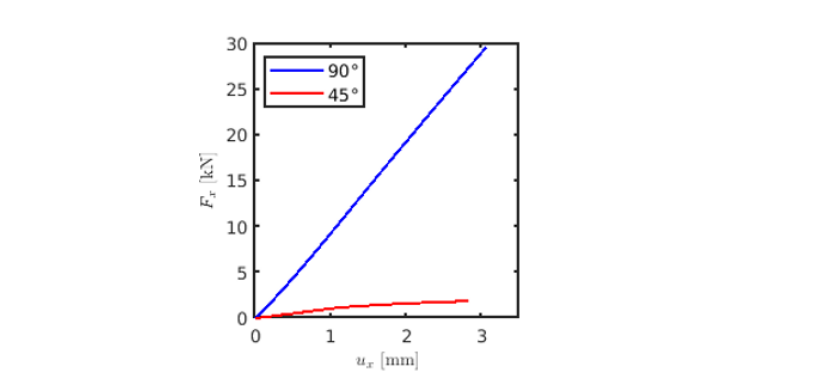
Figure 5 : Load vs. displacement for the two specimens with different orientations (90° and 45°)